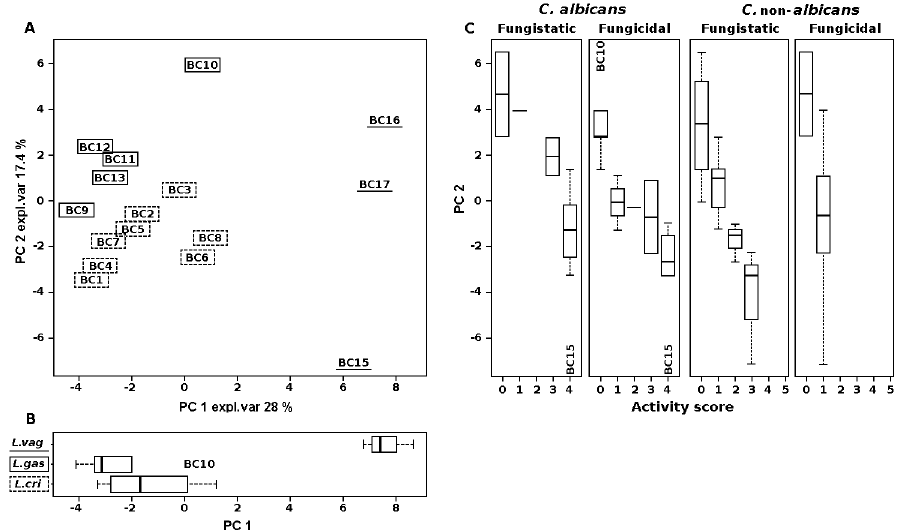
Fig 1. Correlation between metabolome of lactobacilli and fungistatic/fungicidal activity towards C . albicans and C . non- albicans . (A) Biplot of a PCA performed on the total metabolites identified by 1 H-NMR in Lactobacillus cell free supernatants. Expl. Var, explained variance. (B) Box plots representing the distribution of Lactobacillus species in relation to the metabolome. Lines within the boxes indicate the median values of the samples groups corresponding to L . crispatus , L . gasseri and L . vaginalis species. (C) Box plots representing the distribution of fungistatic/fungicidal activity scores towards C . albicans and C . non- albicans in relation to the metabolome. Lines within the boxes indicate the median values of the samples groups corresponding to the different activity scores (0 – 4 for C . albicans ; 0 – 5 for C . non- albicans ). Each box represents the interquartile range (25 – 75th percentile). The bottom and top bars indicate the 10th and 90th percentiles, respectively. Outlier values are indicated (BC10 and BC15).